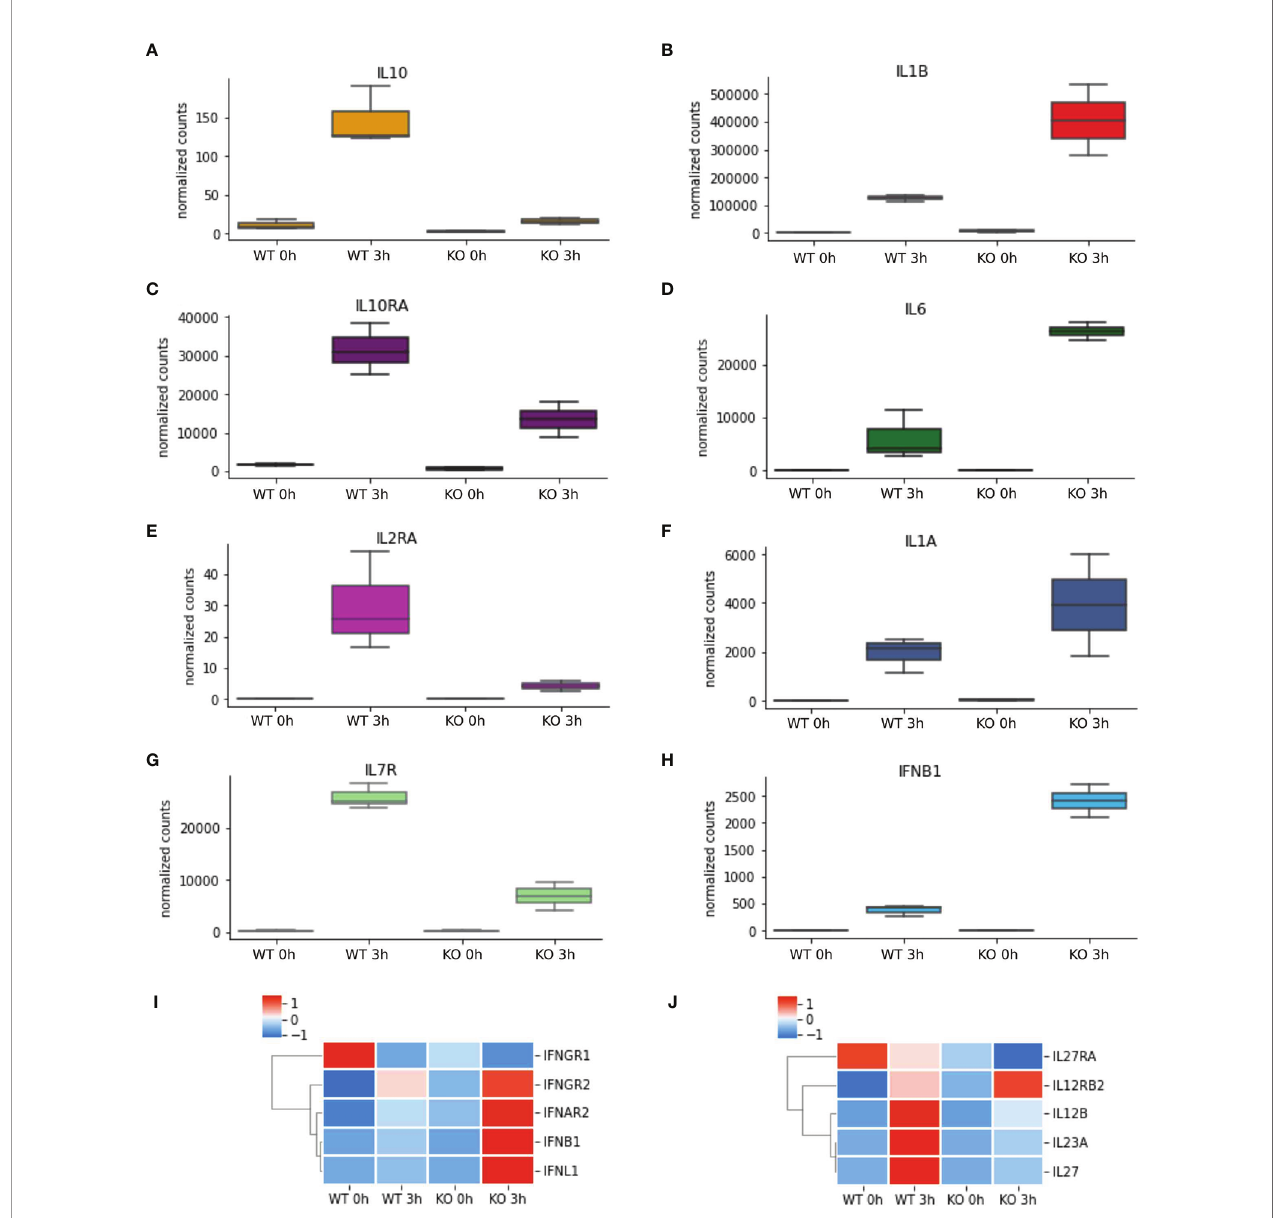
FIGURE 4 | NFKB1 -/- macrophages have an in fl ammatory phenotype. (A – H) RNAseq data of selected differentially expressed cytokine and cytokine receptor genes identi fi ed by Reactome pathway analysis. Heatmaps of differentially expressed (I) interferon cytokines and receptors and (J) IL-12-family of cytokines and receptors from RNAseq analysis, Z-score